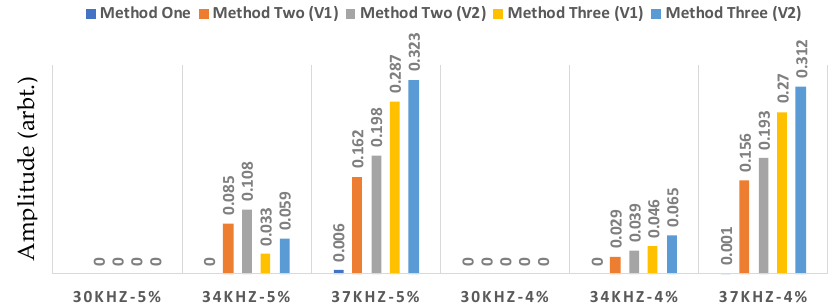
Figure 21. Bar graphs of the Safe zone margins of all methods in the second set of tests.